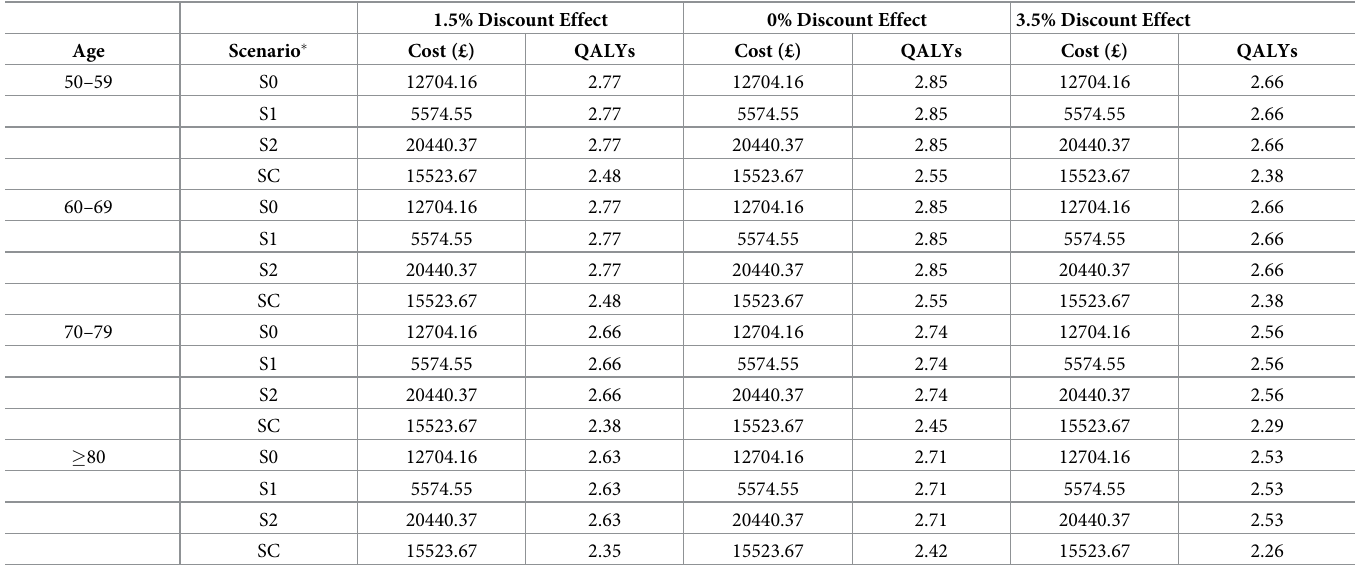
Table 8. Summary cost and QALY outcomes for different age groups, intervention types and at different effect discount rates: Five year interval / one dose per